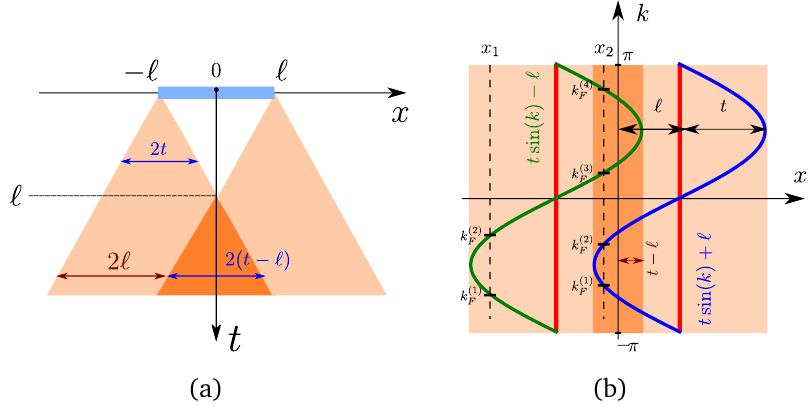
Figure 3: (a) Illustration of the particles spreading during the melting dynamics. From the junctions at x = ± (cid:96) , two lightcones open up and determine the melted region || x | − (cid:96) | < t . At early times t < (cid:96) these lightcones do not intersect and a connected Fermi sea is found at any position x (light-orange region). Conversely, when t ≥ (cid:96) , the particles emitted from one junction penetrate inside the lightcone of the other, leading to a split Fermi sea for | x | ≤ t − (cid:96) (dark-orange region). (b) Graphical solution | ≤ t + (cid:96) (light-orange of Eq. (15) at fixed time t : for any x such that | t − (cid:96) | < | x 1 1 ( 1,2 ) ( x | ≤ t − (cid:96) (dark-orange region), one obtains two Fermi points k , t ) , while for | x 1 2 F ( s ) ( x region) one finds the four solutions k , t ) , s = 1,...,4. In each regime, the values 2 F ( s ) ( x , t ) are given in Eq. (17). Thick red lines denotes the intial position of the roots k F ± (cid:96) of the two domain